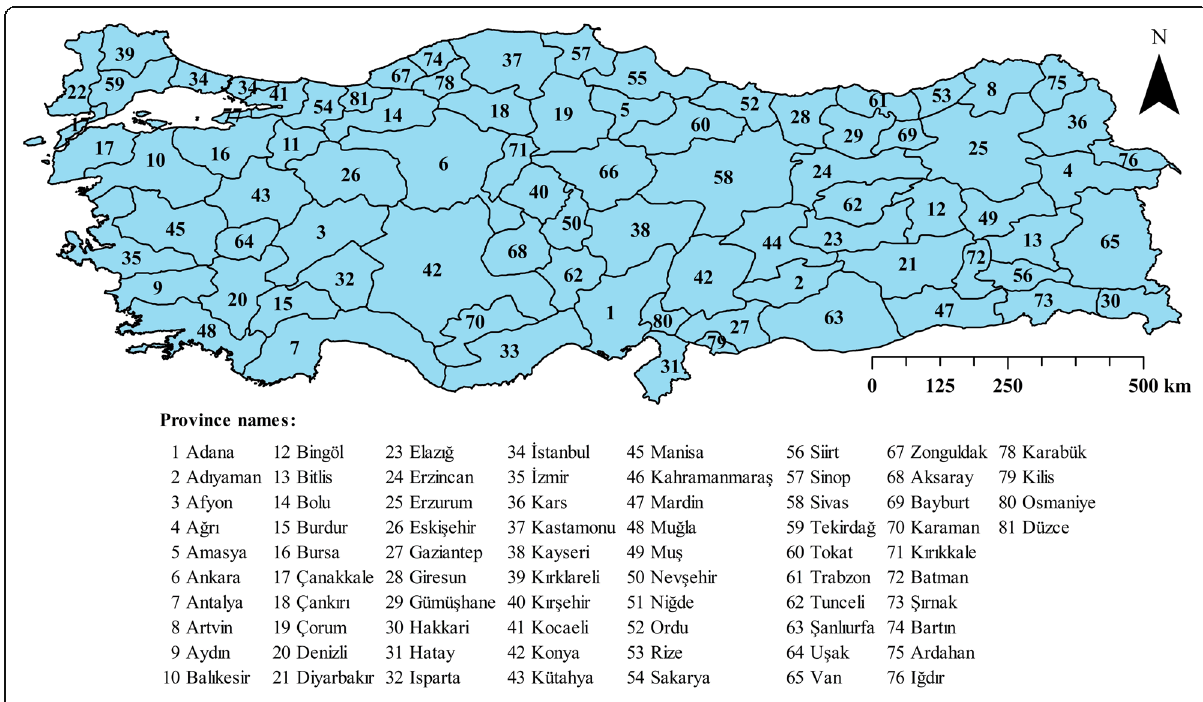
Fig. 1 Studied area and provinces (numerical values are formal plate numbers of